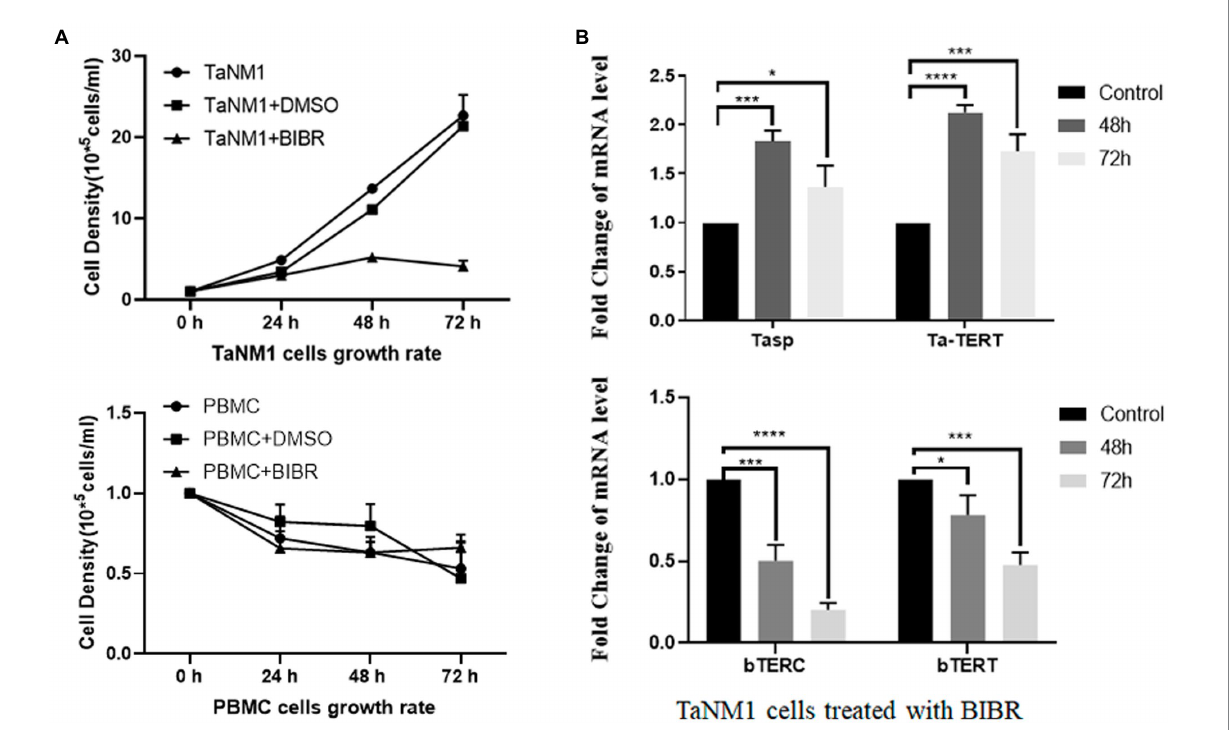
FIGURE 2 Effect of the telomerase inhibitor BIBR on TaNM1 cells: (A) BIBR at a concentration 30 nmol/ml inhibit the proliferation of T. annulata -infected cells, while the dissolve reagent DMSO group had no effect on cell growth compared with the blank control. In PBMC groups, the BIBR has no significant effects on cells proliferation compared with the blank and DMSO control group. Cell numbers were counted daily from three replicate cultures for each condition. (B) Transcriptional analysis of host genes and parasite genes after BIBR treatment. The transcription levels of host cell bTERT and bTERC genes were significantly downregulated after treatment. Transcription of Tasp and Ta-TERT of T. annulata was not restricted by BIBR. The results are the average of three independent experiments. The one-way ANOVA was used for statistical analysis. * p < 0.05, *** p < 0.001, **** p <